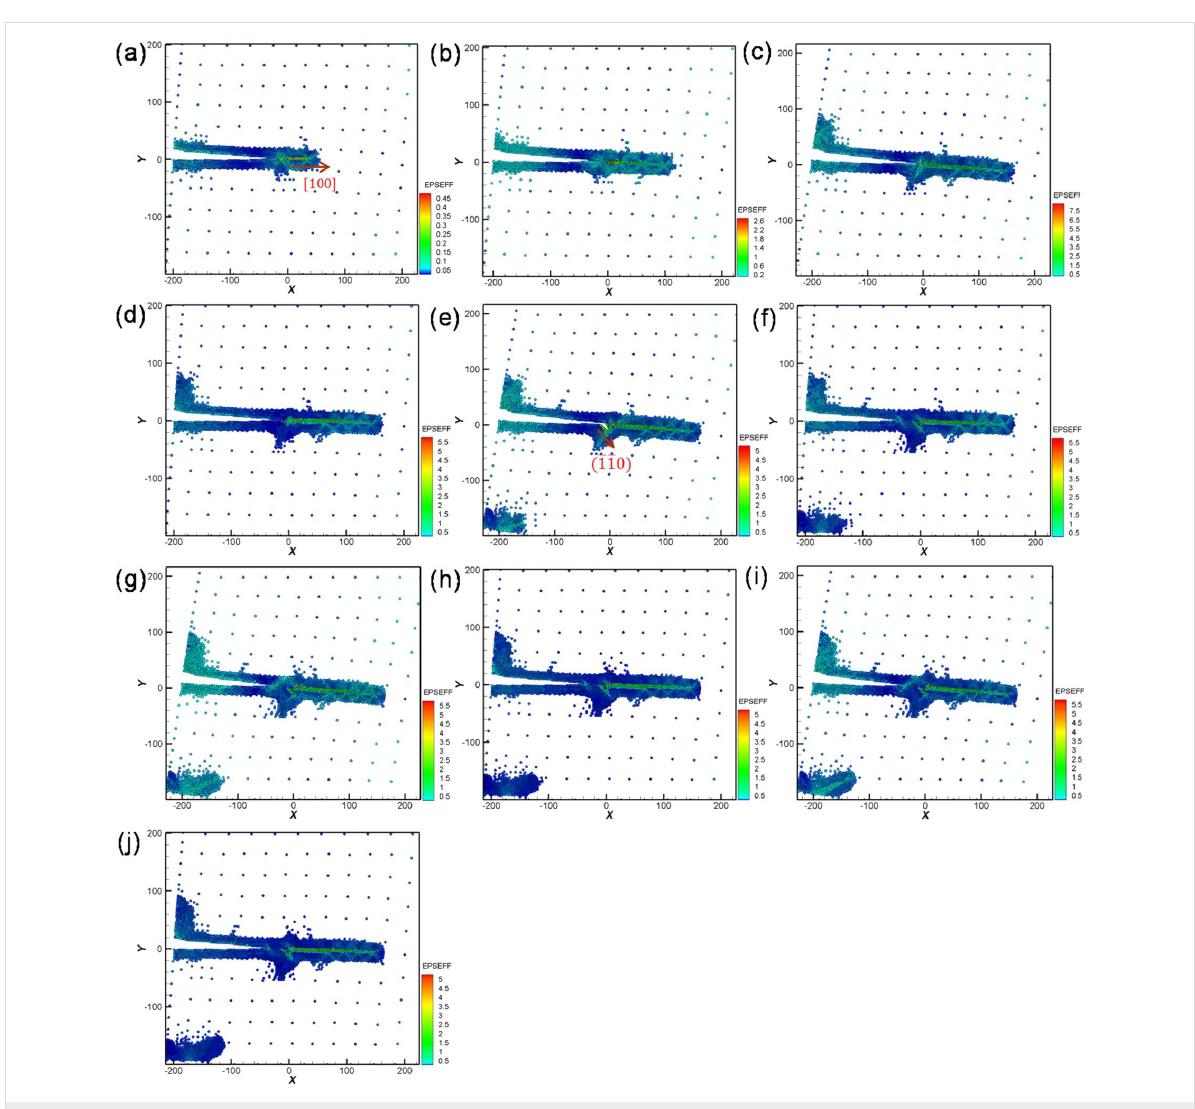
Figure 20: Crack growth and expansion diagrams of Fe along the orientation II corresponding to the observation positons a–j in Figure